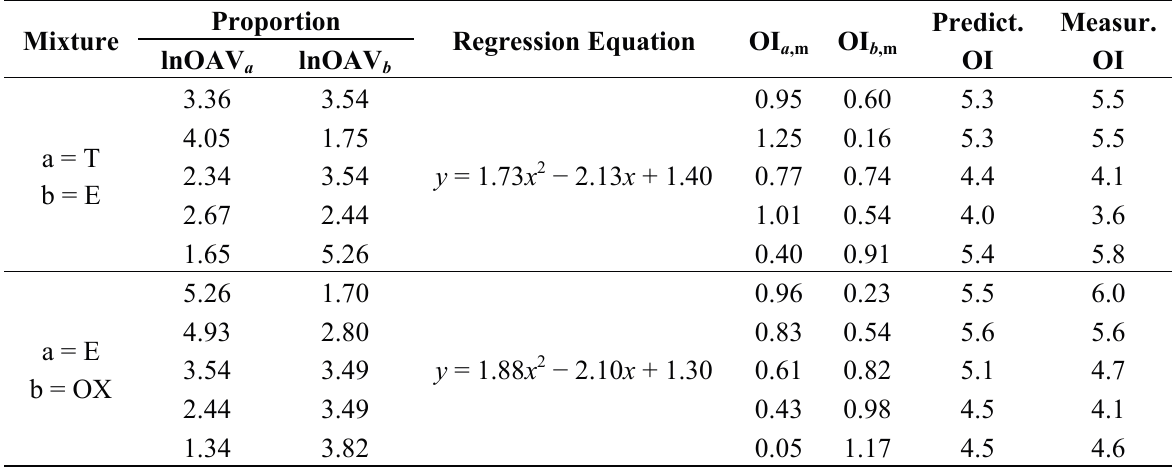
Table 2. Key parameters of PDE model, and comparison between the measured OI and corresponding predicted